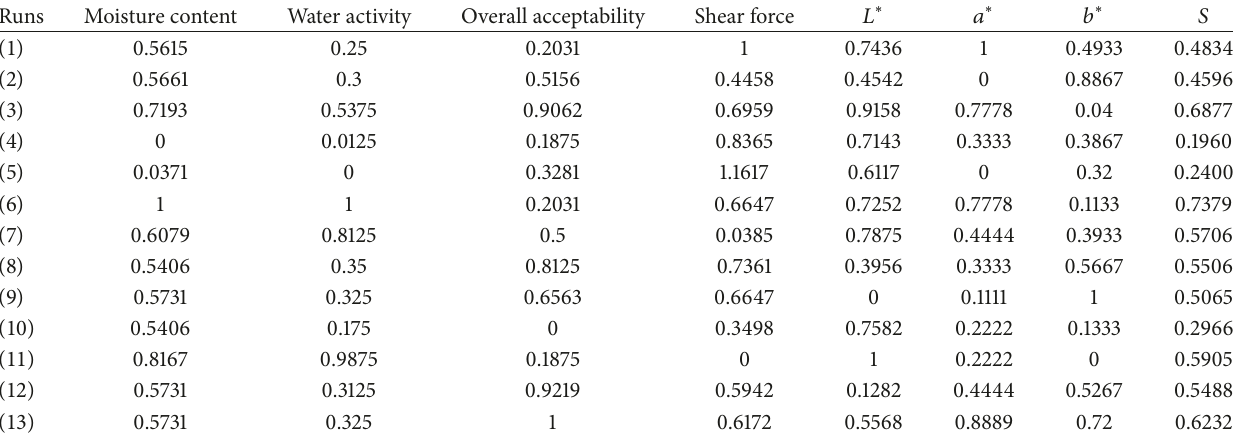
Table 5: Membership value of each response variable and synthetic evaluation index ( 𝑆 ) for response surface design. Runs